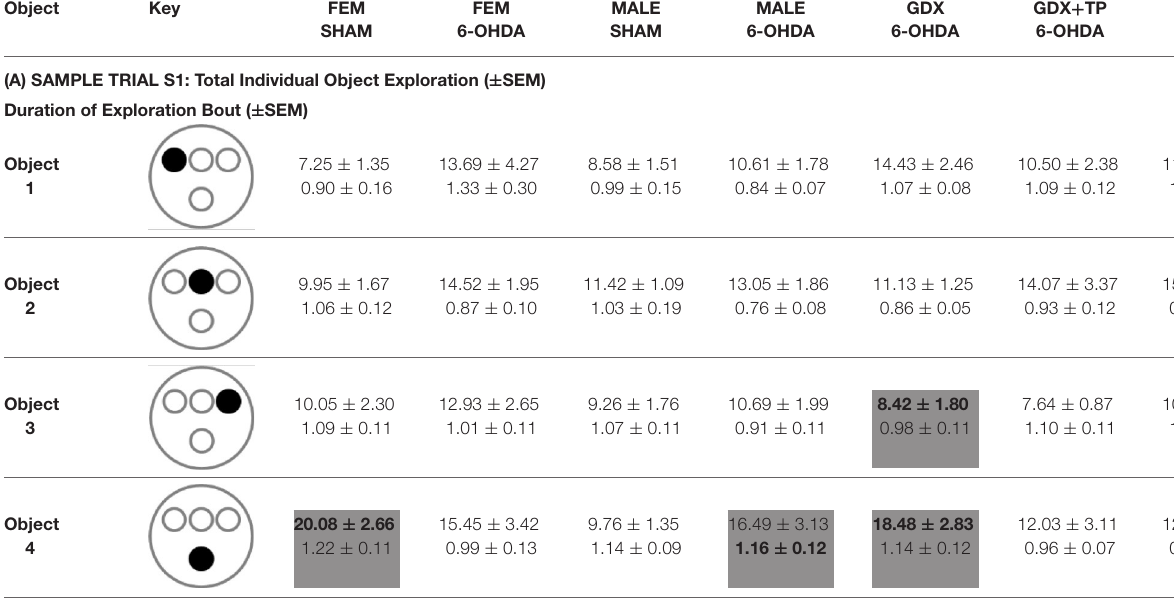
TABLE 3 | Average times (in seconds) of exploration of individual objects during sample trial S1 (A ) and sample trial S2 (B) . Object Key FEM